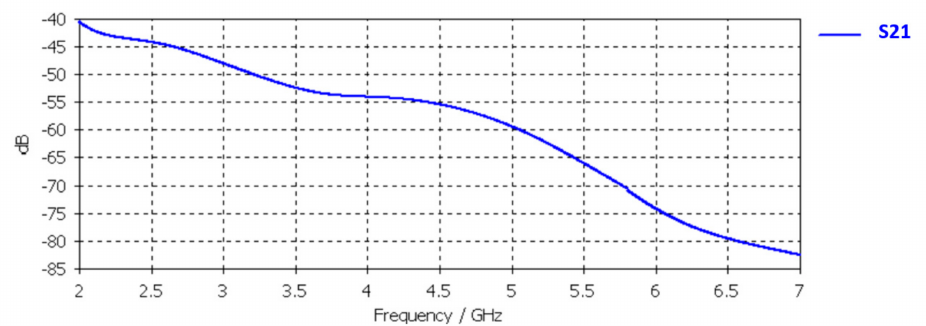
Figure 14. S21 channel parameter between the flexible antenna and UWB